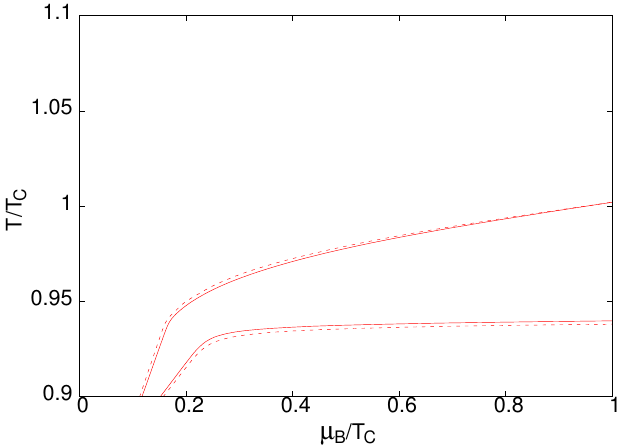
Figure 5. Estimation of the freezeout curve, from Pade estimation of m 1